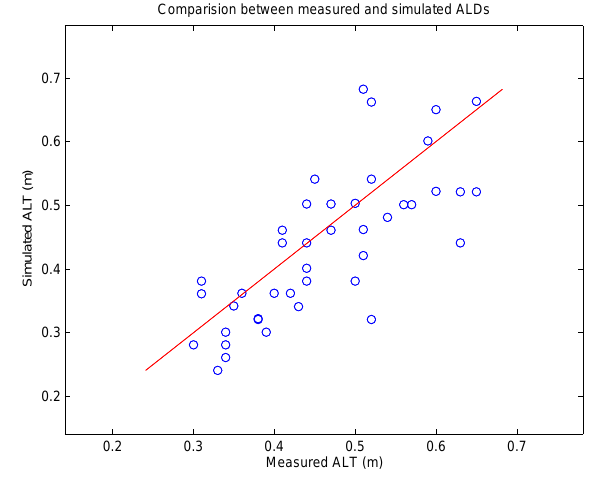
Fig. 5. Simulated and measured MAGTs at different depths from 3 to 30m during 2007–2009 IPY years.